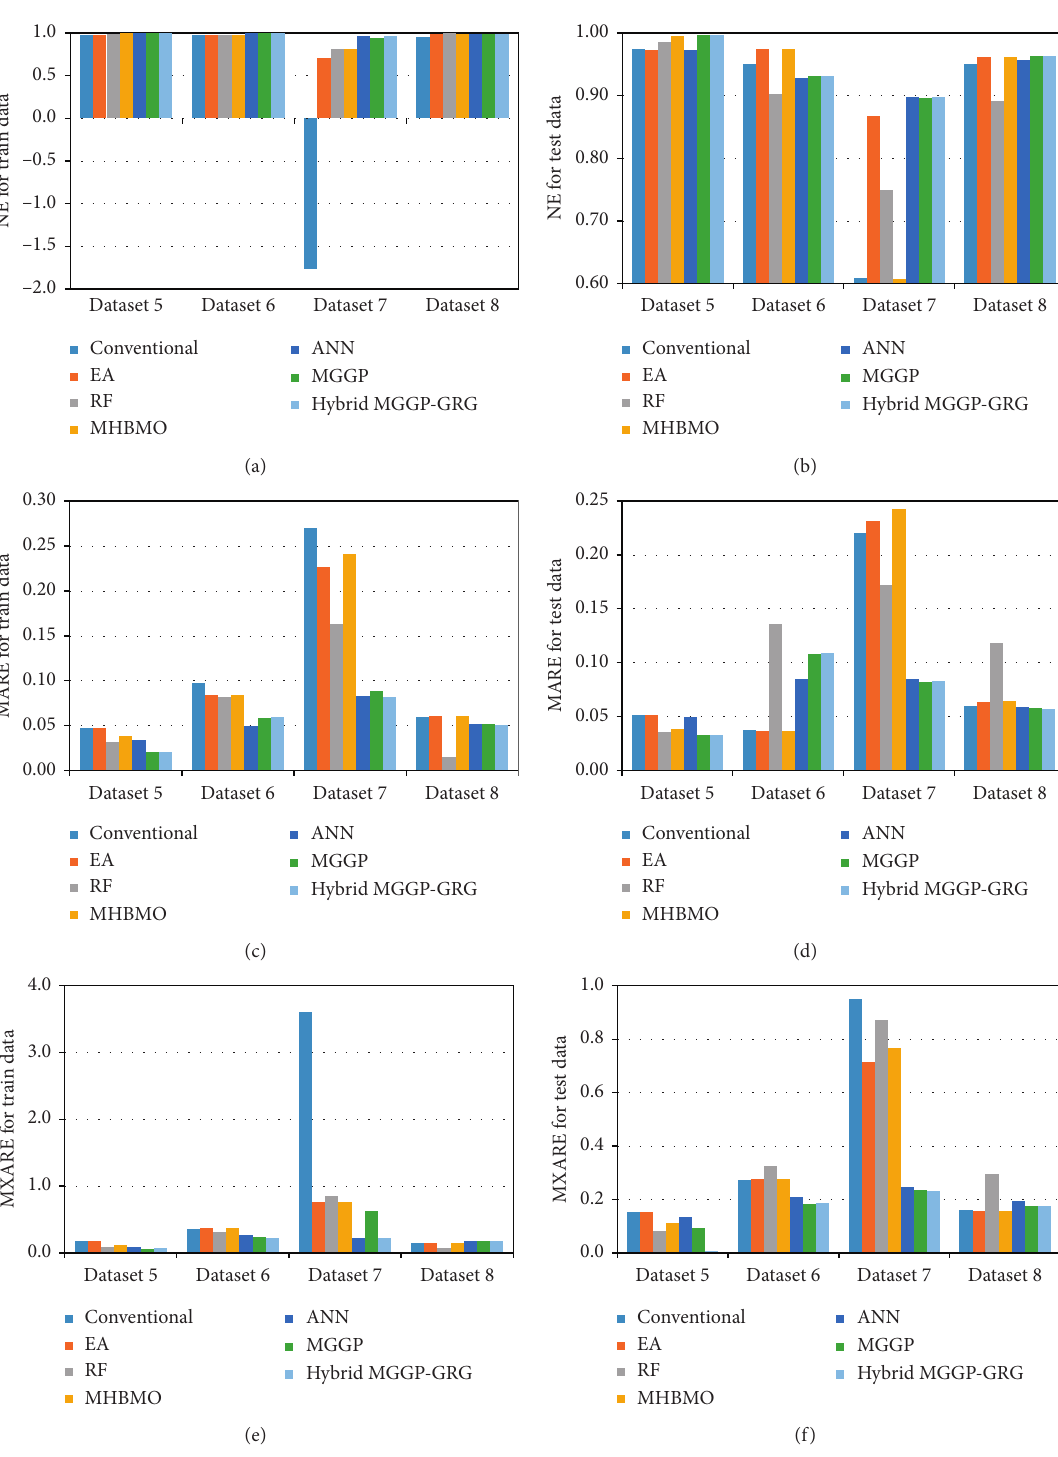
Figure 5: Comparison of the performances of different methods for the data with loop rating curves based on NE, MARE, and